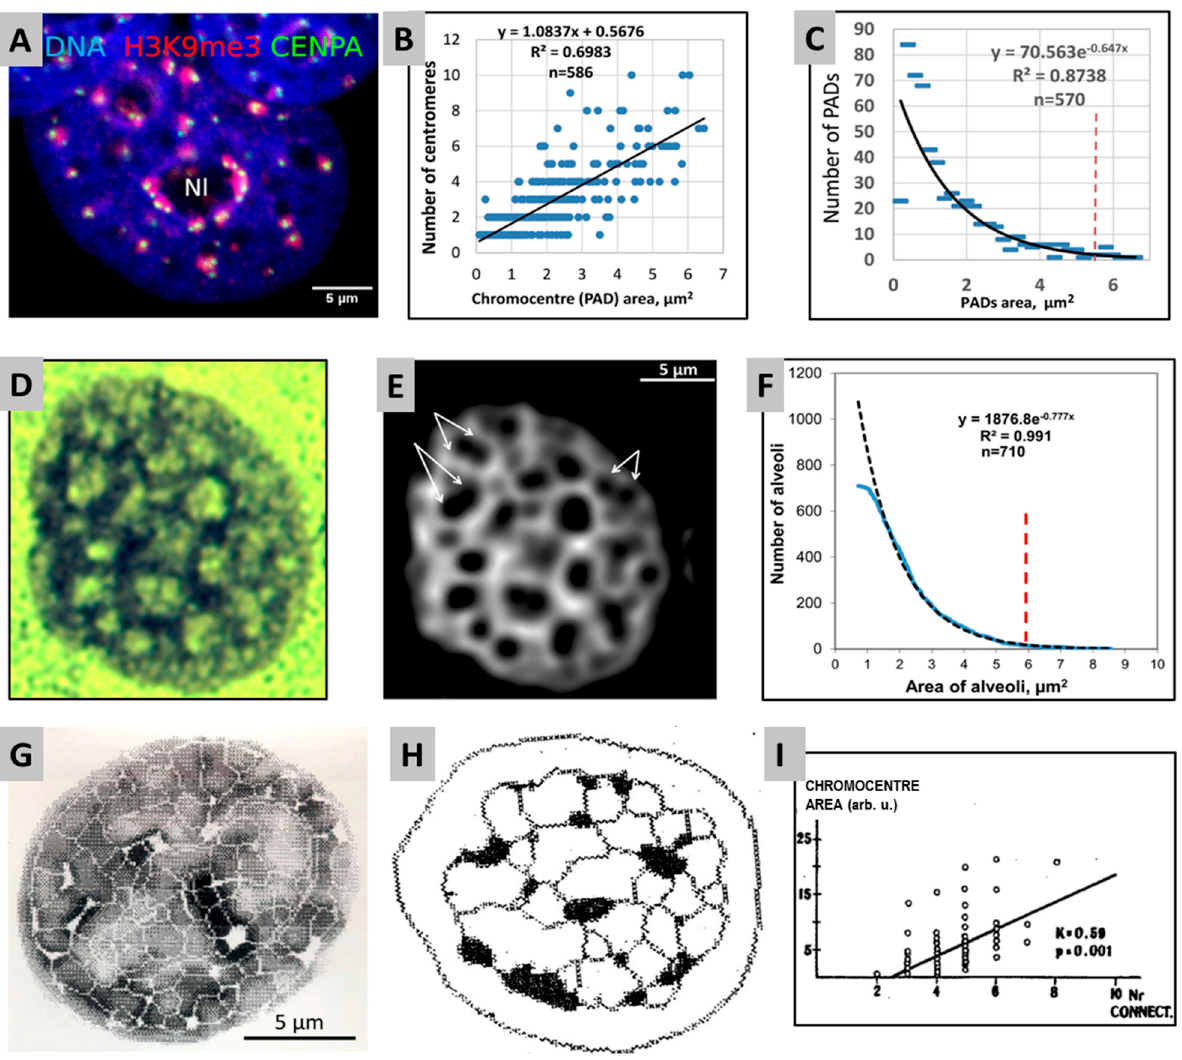
Figure 6. Image analysis data showing the causal relationship between PAD chromocenter clusters and their network in interphase of untreated cell nuclei. ( A , B ) Confocal image of PAD clusters stained for repressive landmark H3K9me3 and centromere protein (CENPA) showing colocalization and also linear relationship between the PAD area and the number of centromeres; ( C ) negative exponential relationship between PAD numbers and their area in MCF-cells; ( D – F ) similarly negative exponential relationship between the number and size of the alveoli of the heterochromatin network (revealed by preferential HR-staining method and image filtration) in the same MCF7 cells (double alveoli are arrowed); ( G – I ) cell nucleus network of chicken embryo femur cartilage stained by toluidine blue stoichiometrically for DNA determination; ( G ) skeletonized chromatin network and chromocenters are overlaid onto the half-tone image; ( H ) another nucleus image showing the overlay of separately discriminated dense chromocenters and skeletonized chromatin network; ( I ) positive relationship between the area of the chromocenters and the number of branches from them confirming the origin of the network by the chromocenter clustering. (Note: This figure and a slightly modified figure legend was originally published under CC-BY license in